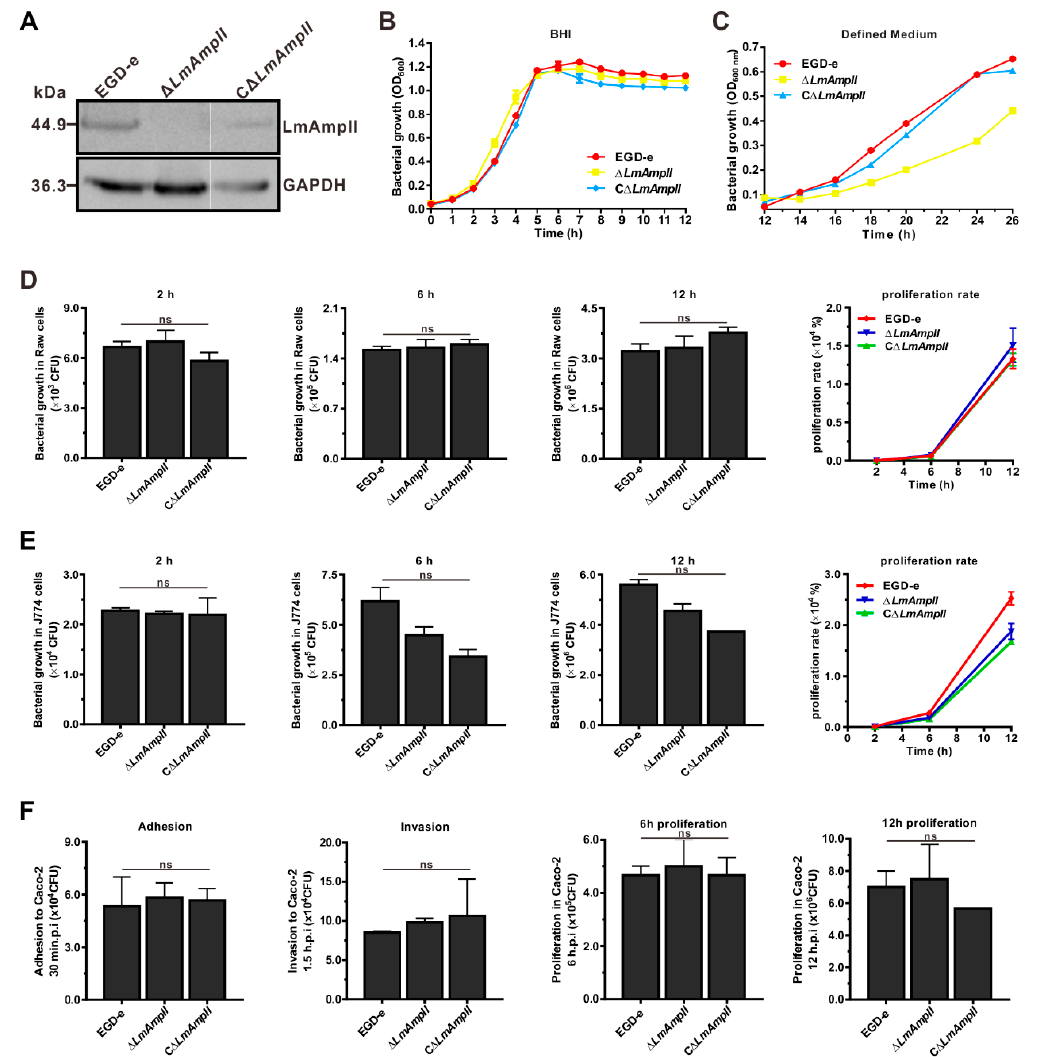
Figure 4. LmAmpII is required for bacterial growth in a chemically defined medium for optimal growth of L. monocytogenes , but not for intracellular infection and virulence. ( A ) Construction of the LmAmpII deletion and complemented mutants, and protein expression was detected by Western blotting. ( B , C ) Growth curves of L. monocytogenes bacteria in the brain heart infusion (BHI) medium ( B ) and chemically defined medium ( C ). ( D , E ) Intracellular growth of L. monocytogenes in murine-derived Raw264.7 ( D ) and J774A.1 ( E ) macrophages. Gentamicin (50 µ g / mL) was added 30 min post-infection. Cells infected with L. monocytogenes strains that were lysed at the indicated time points (2, 6, and 12 h), and viable bacteria were numbered by serial plating on BHI agar plates. ( F ) Adhesion, invasion, and proliferation of L. monocytogenes in human intestinal epithelial cells Caco-2. Cells infected with bacteria were lysed at the indicated time points, and viable bacteria were serially plated on BHI agar plates. The number of recovered bacteria shown that were able to invade cells and survive represent the mean ± SD for each strain. ns, not significant.